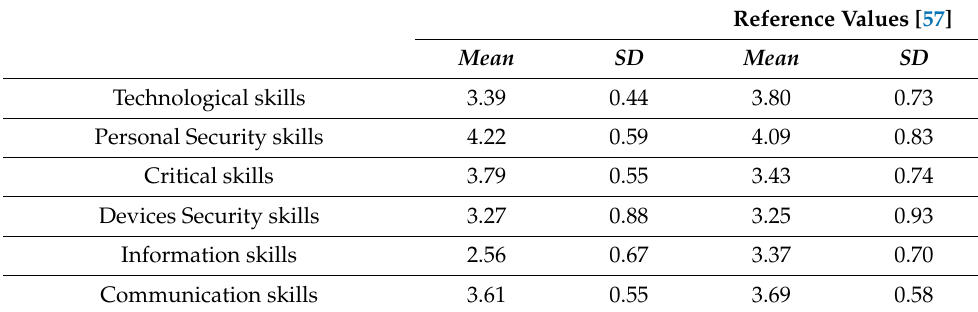
Table 4. Digital Literacy Scale. Source: Authors’